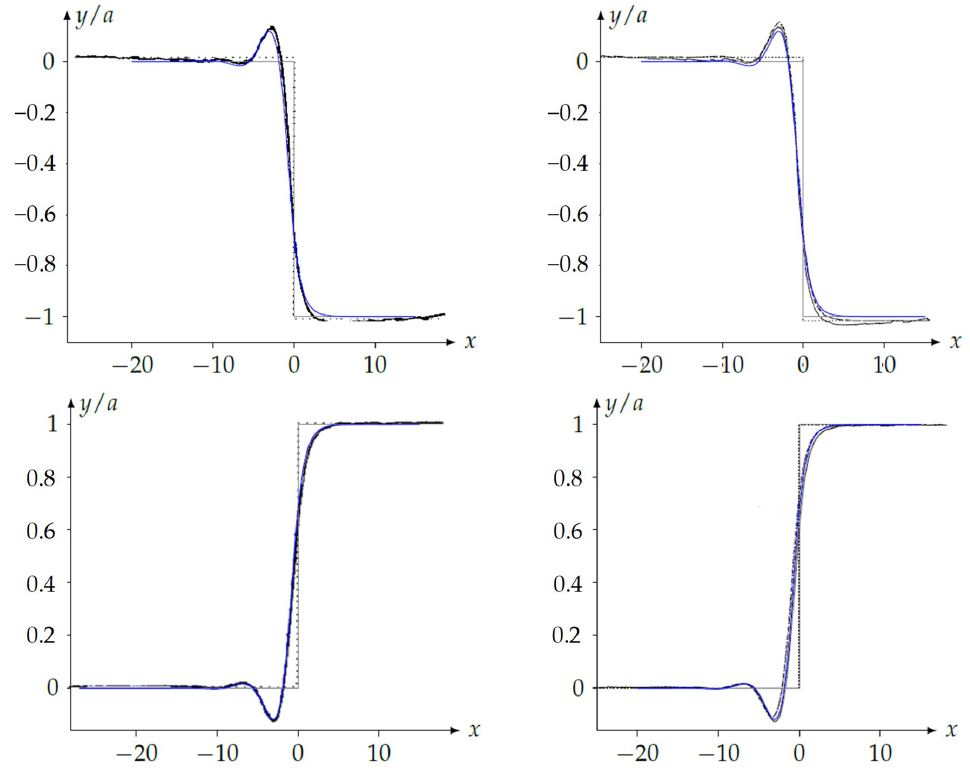
Figure 2. Comparison of the free surface disturbance predicted by (41) (blue curve) against the experimental data (dashed curve) of [10] (left column) as well as the numerical solution (black curve) of Gaskell et al. [17] (right column), both for a step-down (top row) and a step-up (bottom row) topography: the flow is from left to right with α = 30°, and Ca = 7 × 10 − 4 and the dotted line shows the associated nature of the topography for comparison